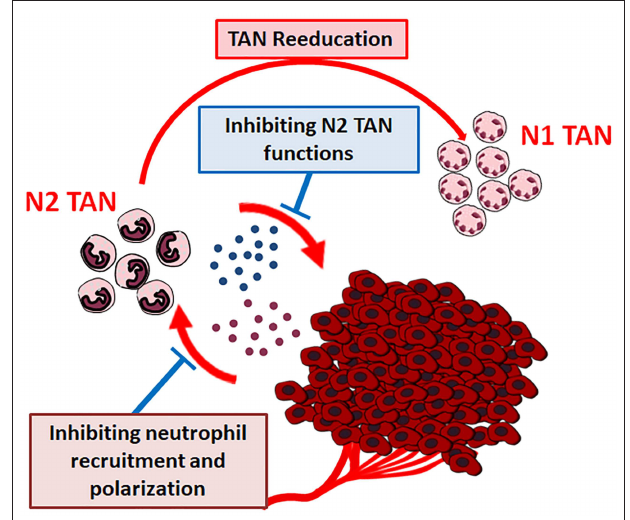
FIGURE 5 | Therapeutic strategies for cancer neutrophils